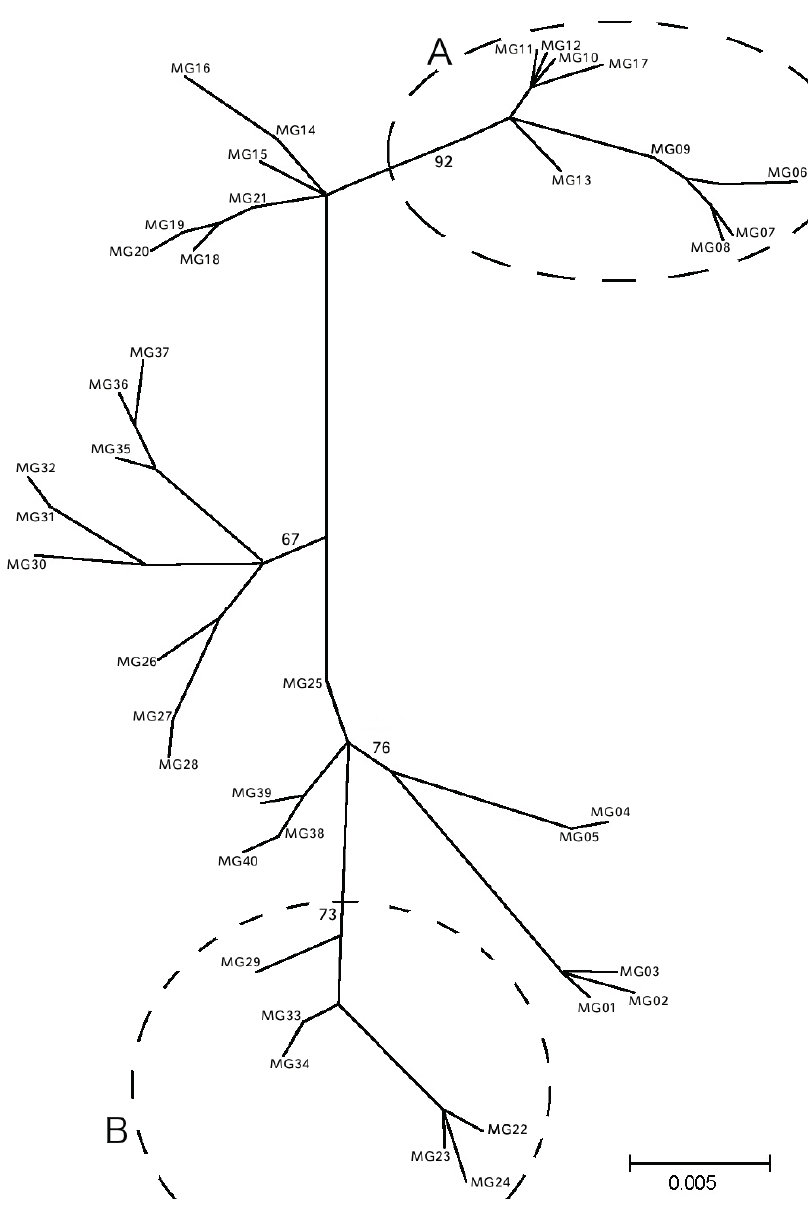
Figure 2. Maximum likelihood dendrogram of the haplotypes found. Group A and B consist mainly from Turkish and Croatian populations, respectively. Population codes as listed in Table 2. Bootstrap values greater than 60% are demonstrated on the